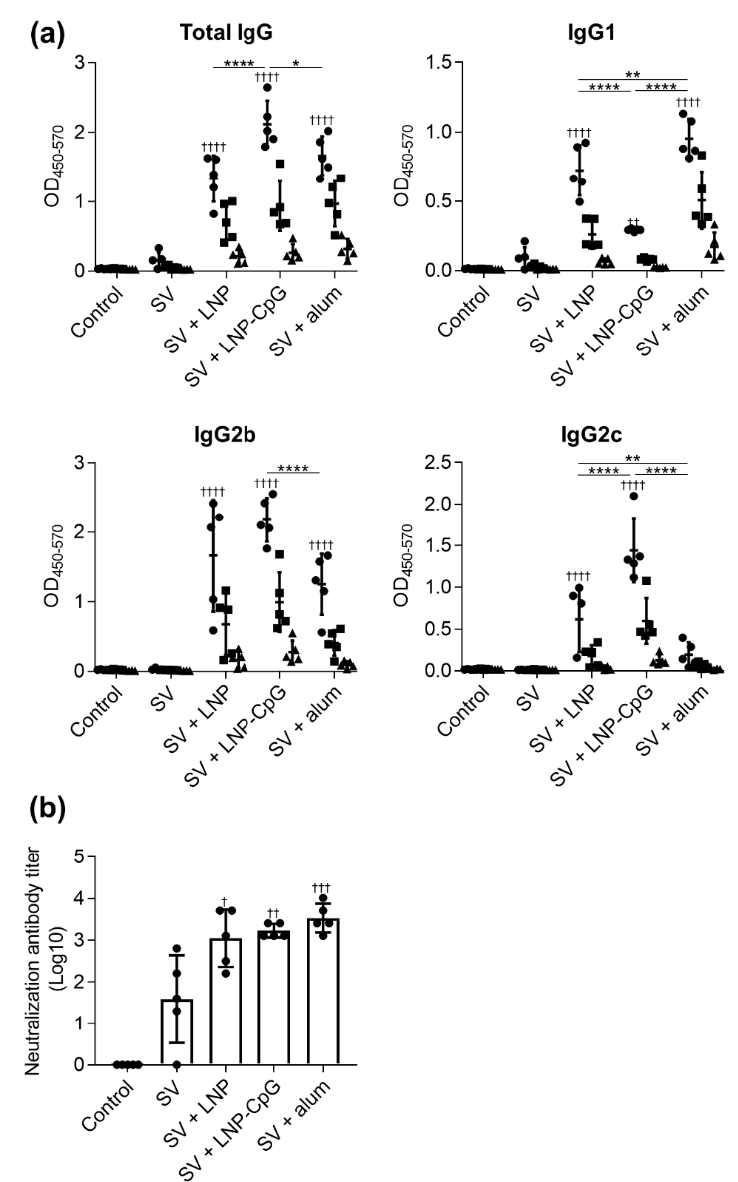
Figure 3. SV-specific antibody responses in vivo after second immunization. Mice were subcutaneously immunized with the SV alone, SV plus LNP, SV plus LNP-CpG, or SV plus alum on days 0 and 21. ( a ) On day 28, levels of SV-specific total IgG, IgG1, IgG2b, and IgG2c in plasma were evaluated by using ELISA. We used 4000- ( ● ), 20,000- ( ■ ), and 100,000- ( ▲ ) fold diluted plasma samples. ( b ) Neutralization titers in plasma samples against Cal7 were evaluated. ( a , b ) n = 5 per group. Data are means ± SD. ( a ) Significant differences were only analyzed in the 4000-fold-diluted plasma samples. ( a,b ) † p < 0.05, †† p < 0.01, ††† p < 0.001, and †††† p < 0.0001 vs. group immunized with the SV alone; * p < 0.05, ** p < 0.01, and **** p < 0.0001, as indicated by Tukey’s test.